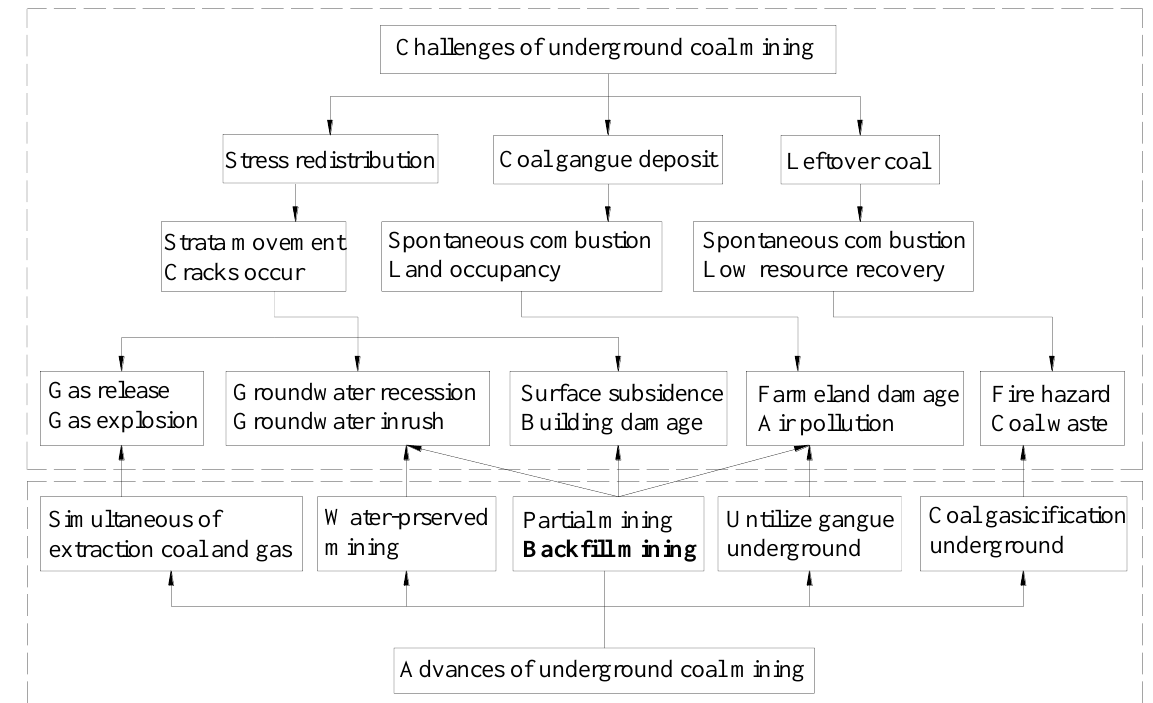
Figure 1. The theoretical and technical framework of underground coal green mining [6].